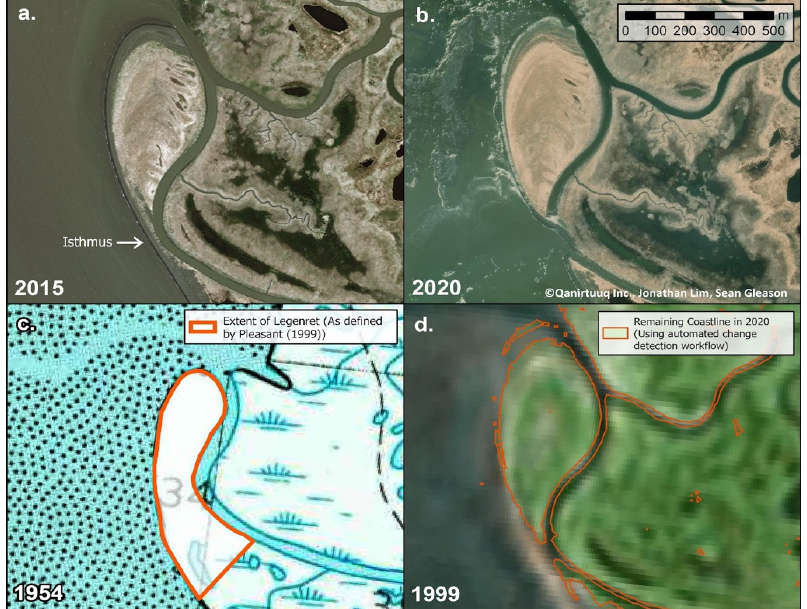
Figure 3. Erosion of the Legenret peninsula at the mouth of the Uyak (Oyak) creek, near Quinhagak, southwest Alaska. ( a ) and ( b ): Planet satellite imagery at 3 m resolution, ( c ): the extent of the peninsula as defined by USGS in 1954; ( d ) the result of automated coastline change detection. Reproduced from [12] with permission of the authors.